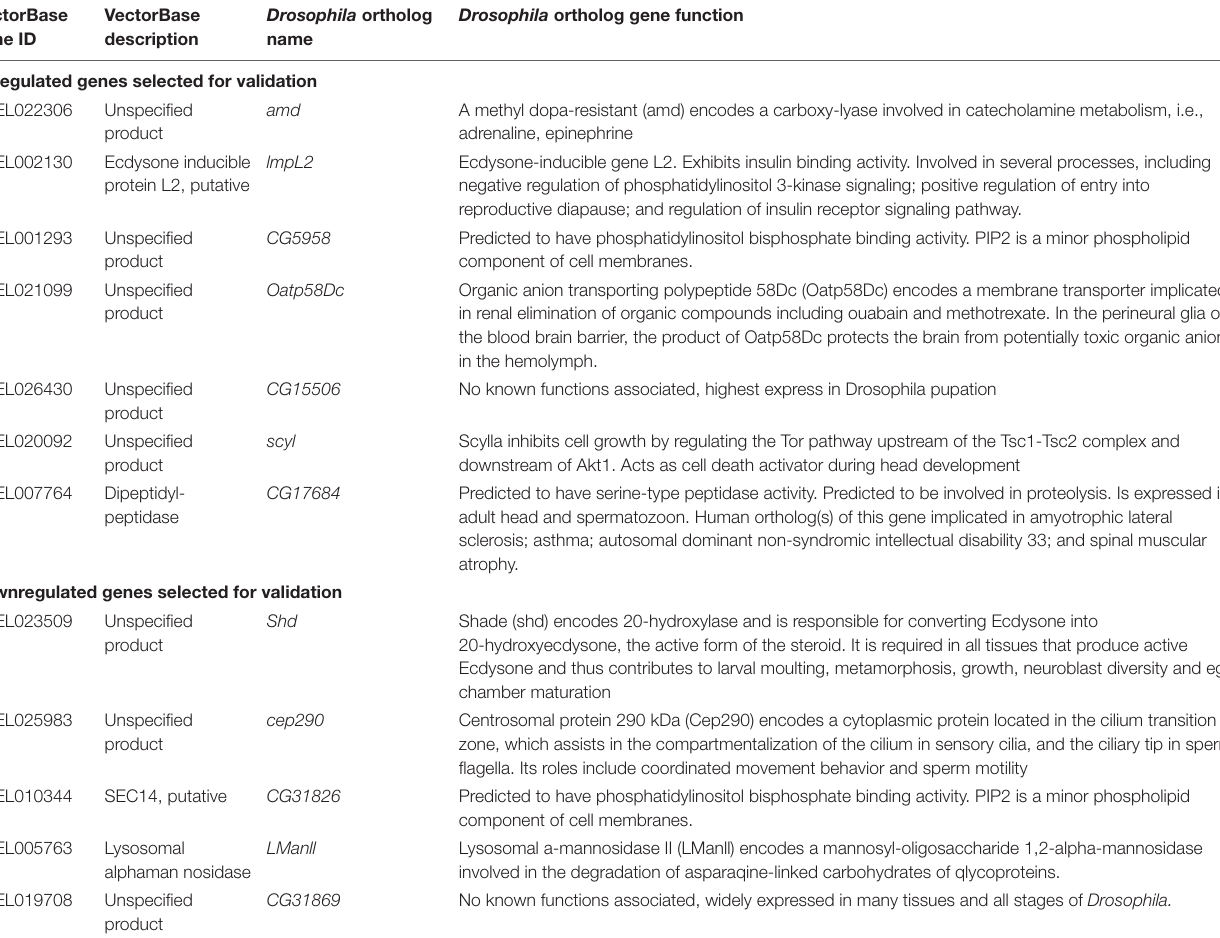
TABLE 1 | Aedes aegypti ovarian genes with differential expression in blood feeding with DENV-2 selected for RT-qPCR validation. VectorBase VectorBase Drosophila ortholog Drosophila ortholog gene gene ID description name